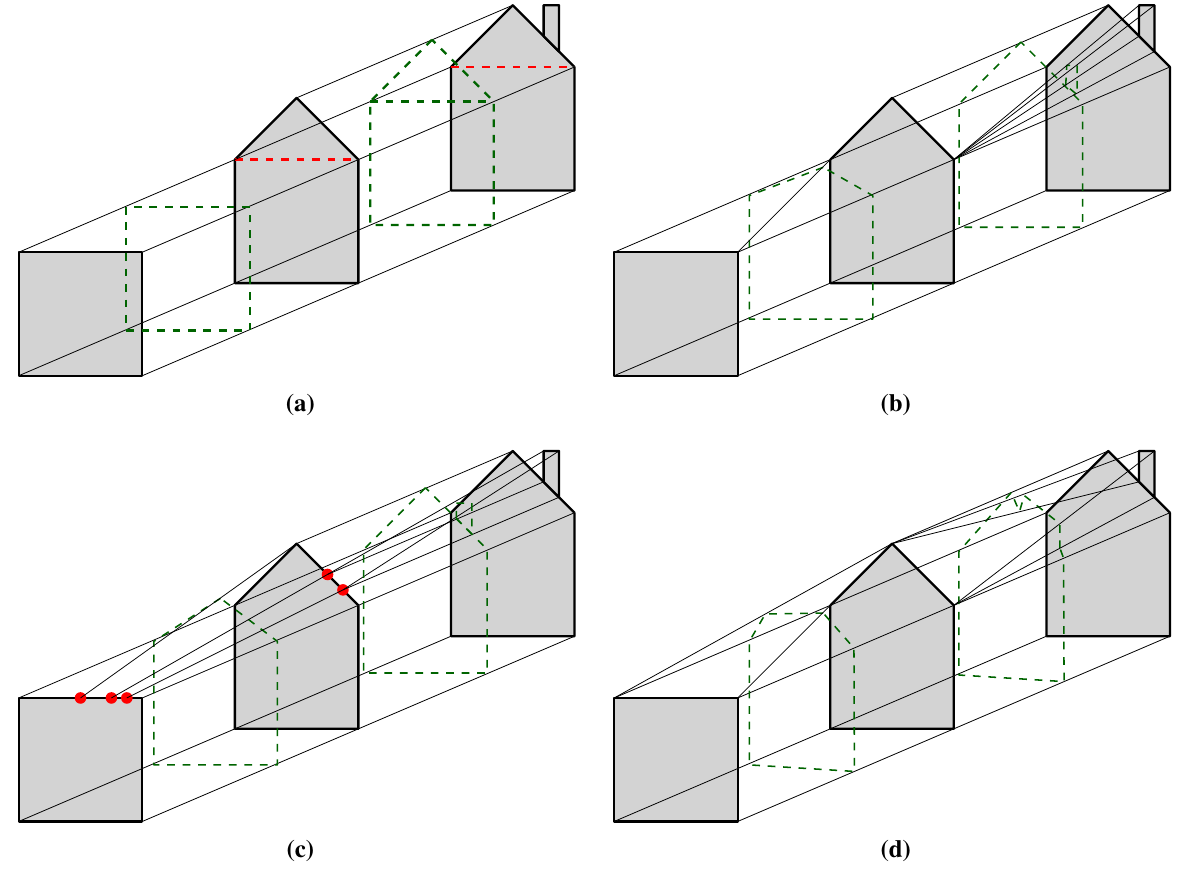
Figure 1. The four linking schemes for three levels of detail (LODs) of a house, here depicted in 2D: ( a ) simple linking. ( b ) unmatched are collapsed. ( c ) modification of topology and ( d ) matching all to existing. The objects that would be obtained by slicing between the LODs can be seen in dashed green contours; the red dashed lines reflect the cells that need to be added and split in order to ensure a valid 3D (2D + LOD) cell